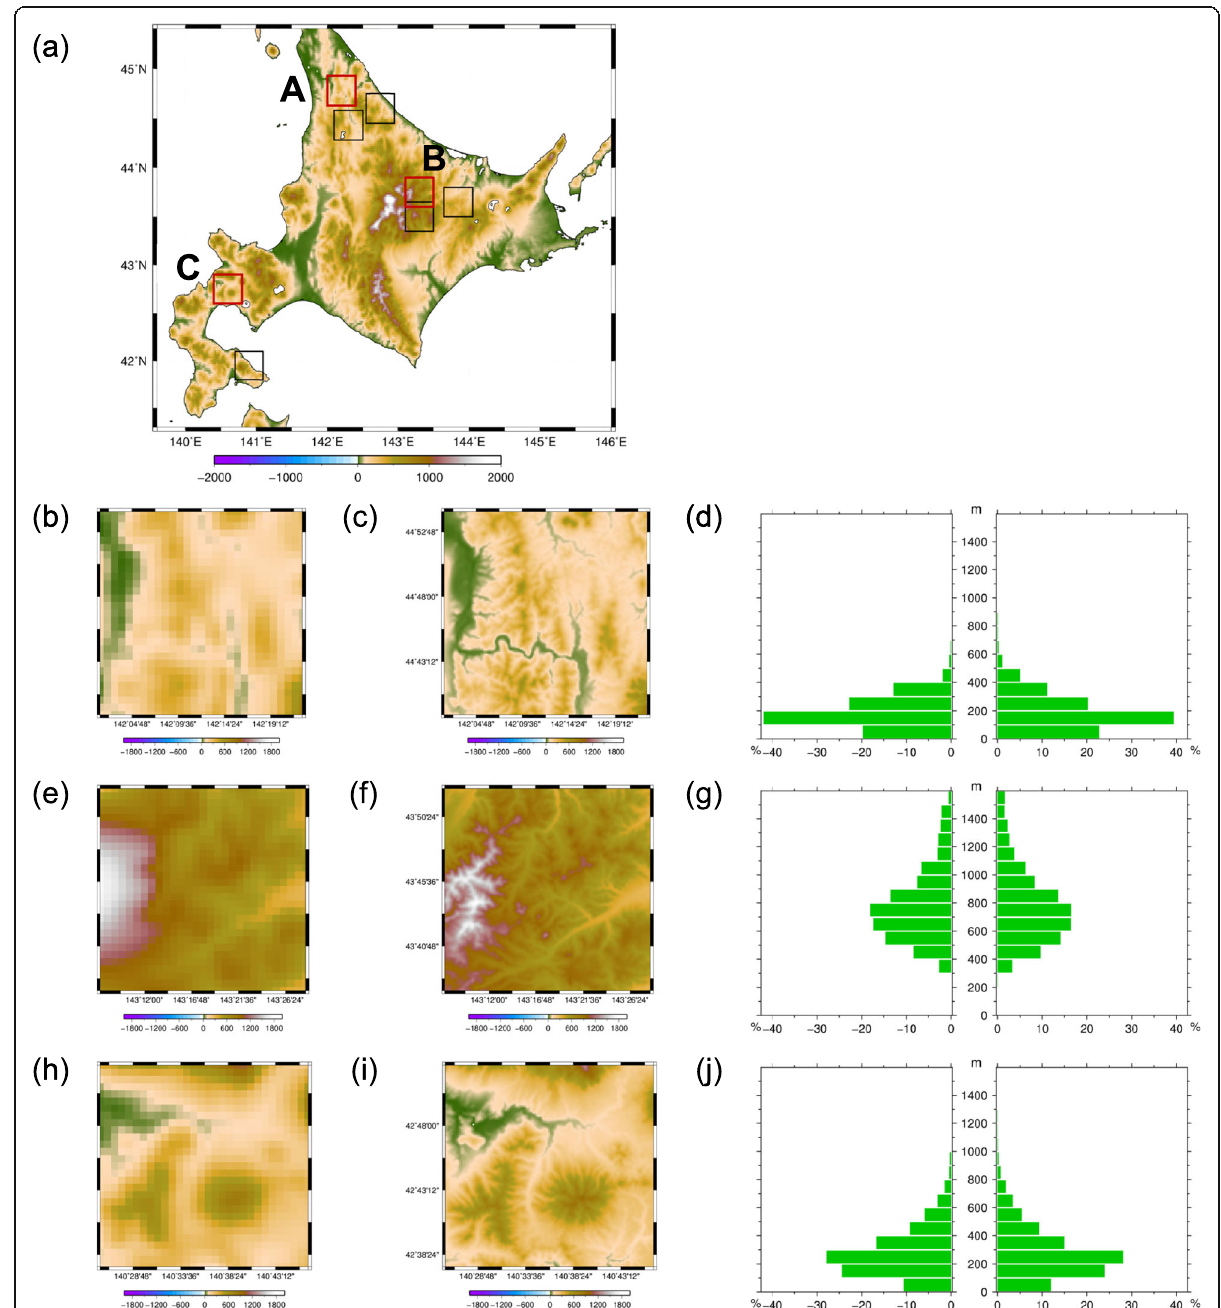
Fig. 4 Terrain features of the analysis areas. a Terrain height and the D04 areas in D03. Red boxes denoted as A, B, and C are the analysis areas. The terrain height in the area A ( b ) at the 1-km grid spacing in D03 and ( c ) at the 200 m grid spacing in D04. d The frequency distribution of terrain height in the area A (left) at the 1 km grid and (right) at the 200 m grid. e, f, g The same as ( b , c, d ) except for the area B. h, i, j The same as ( b , c, d ) except for the area